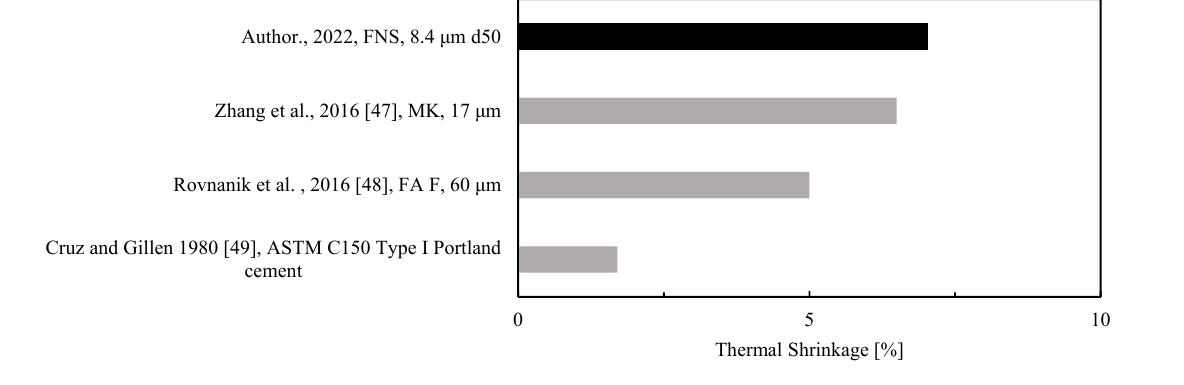
Figure 6. Thermal shrinkage of low-calcium AAM pastes after exposure to a thermal load between 800 and 1000 °C.